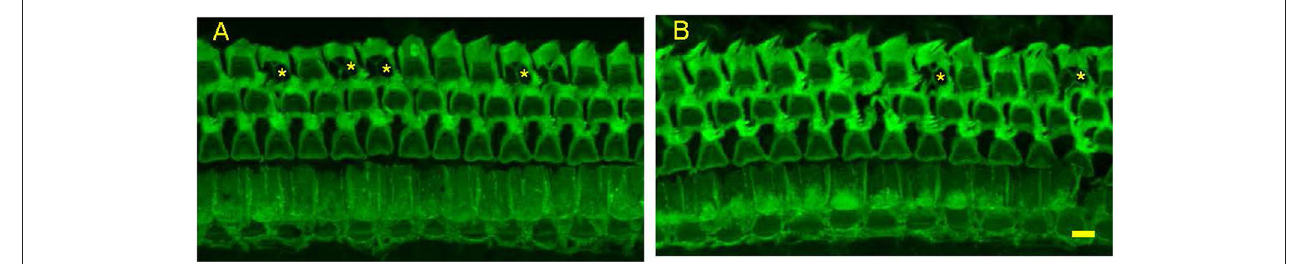
FIGURE 4 | Representative photomicrographs from surface preparations of organ of Corti from a 24 months old Control Diet mouse (A) and a 24 months old mouse on the Rapamycin Diet (B) Both have outer hair cell loss in the third row, with scars marked by asterisks. Bar = 10 µ